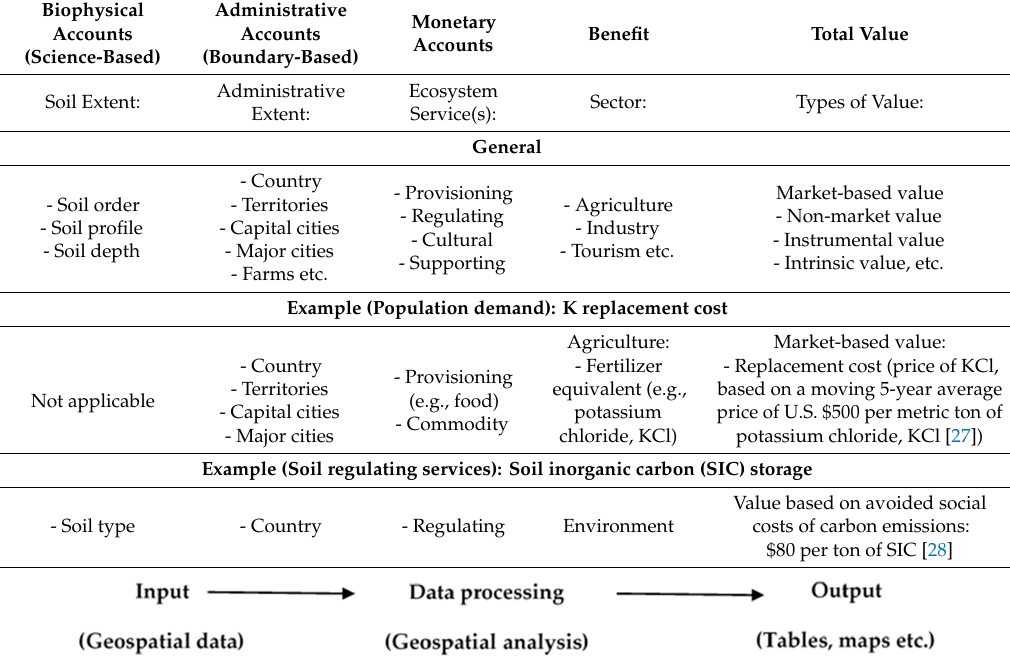
Table 6. Using soil databases within an existing ecosystem service (ES) accounting framework (adapted from [26]) with geospatial